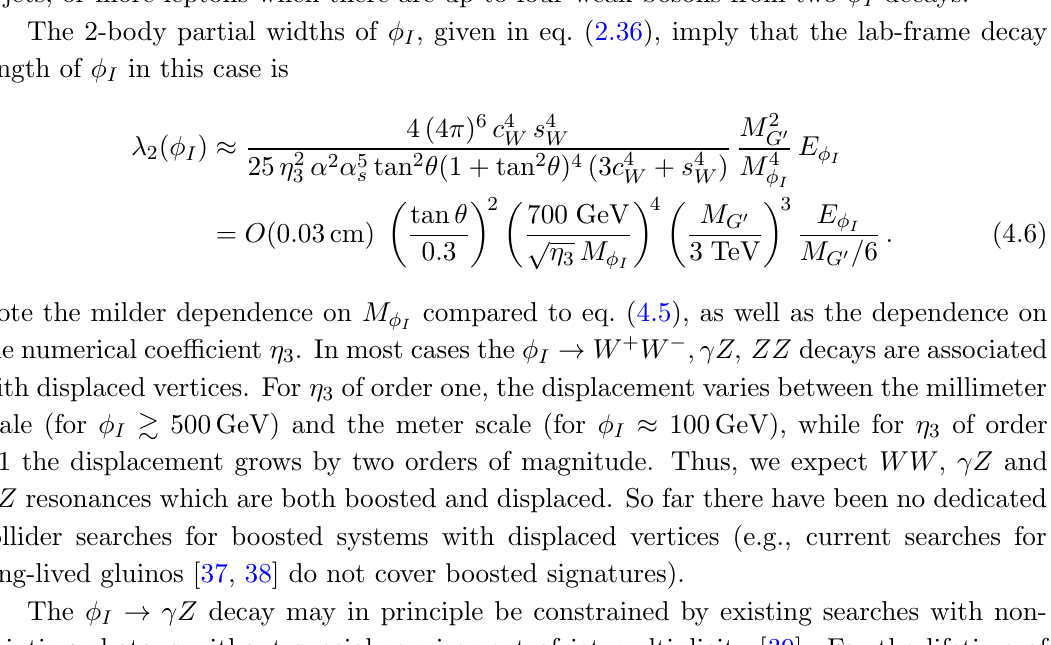
Figure 14 . Representative LHC processes from symmetric coloron decays, for M decays into pairs of electroweak bosons at three loops (represented by the largest gray disc). The (cid:13)Z and W + W (cid:0) systems are likely to be boosted and to originate from displaced